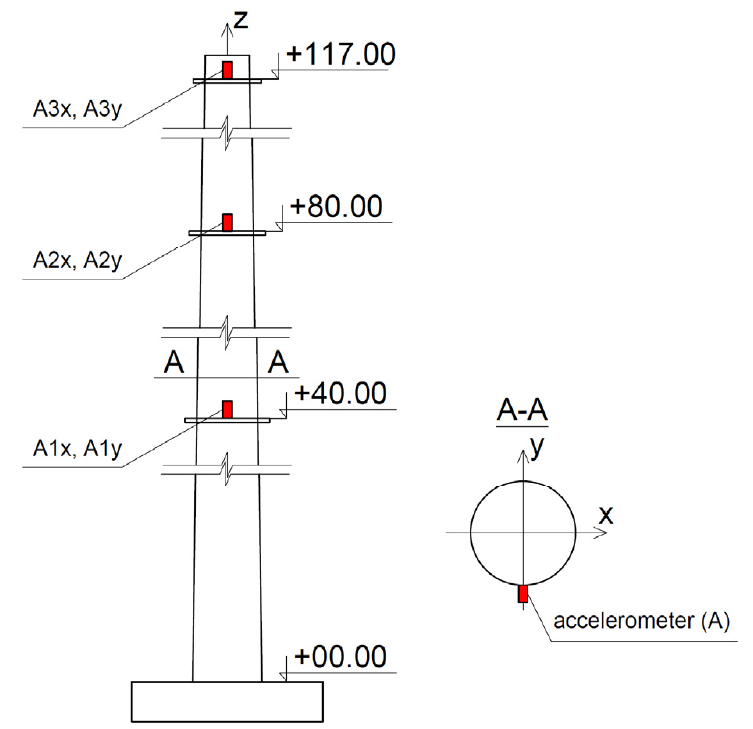
Figure 5. The arrangement of the accelerometers on the chimney